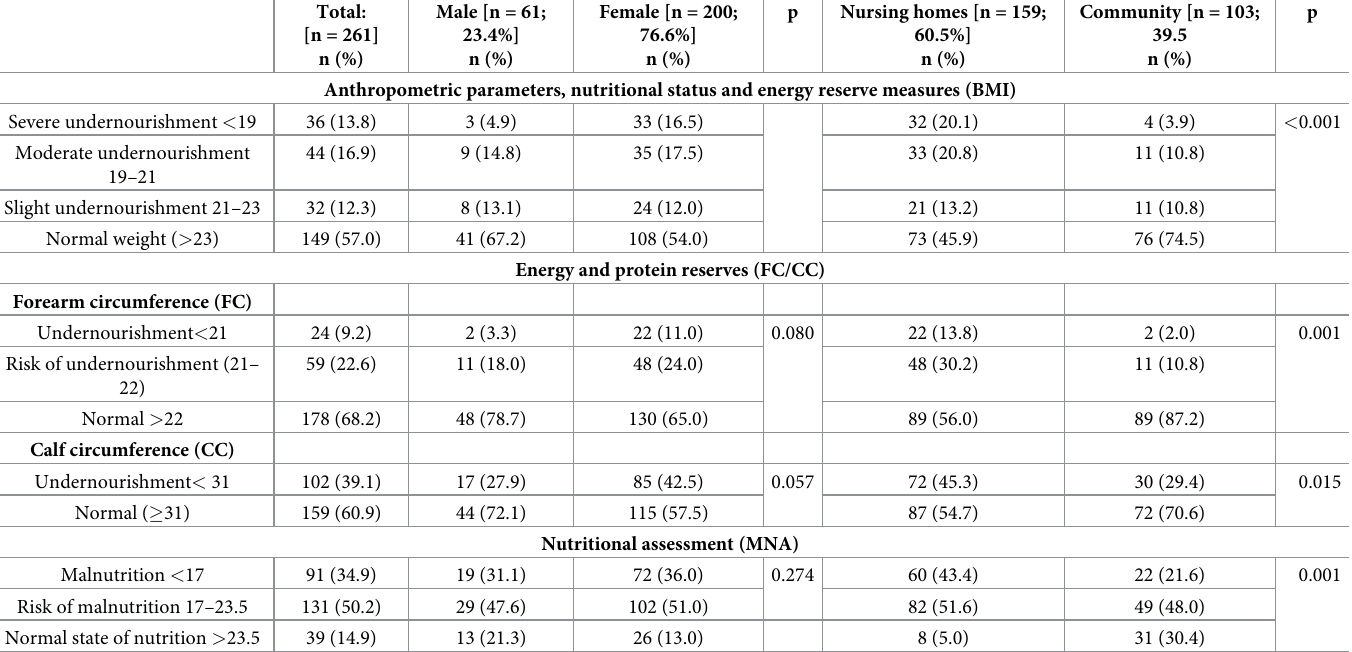
Table 2. Anthropometric parameters, nutritional status and energy reserve